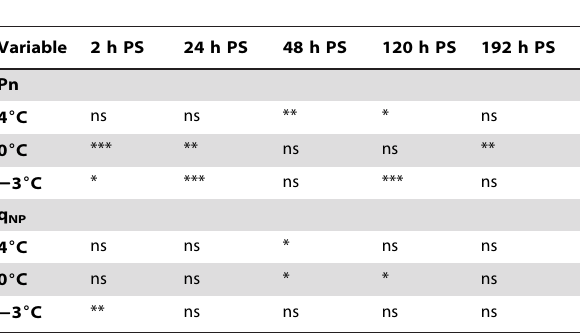
Table 2. Results of one-way ANOVA of the impact of night temperature on net photosynthesis (Pn) and stalk non- photochemical quenching (q NP ), compared to the control, at each time point. PS, post stress.